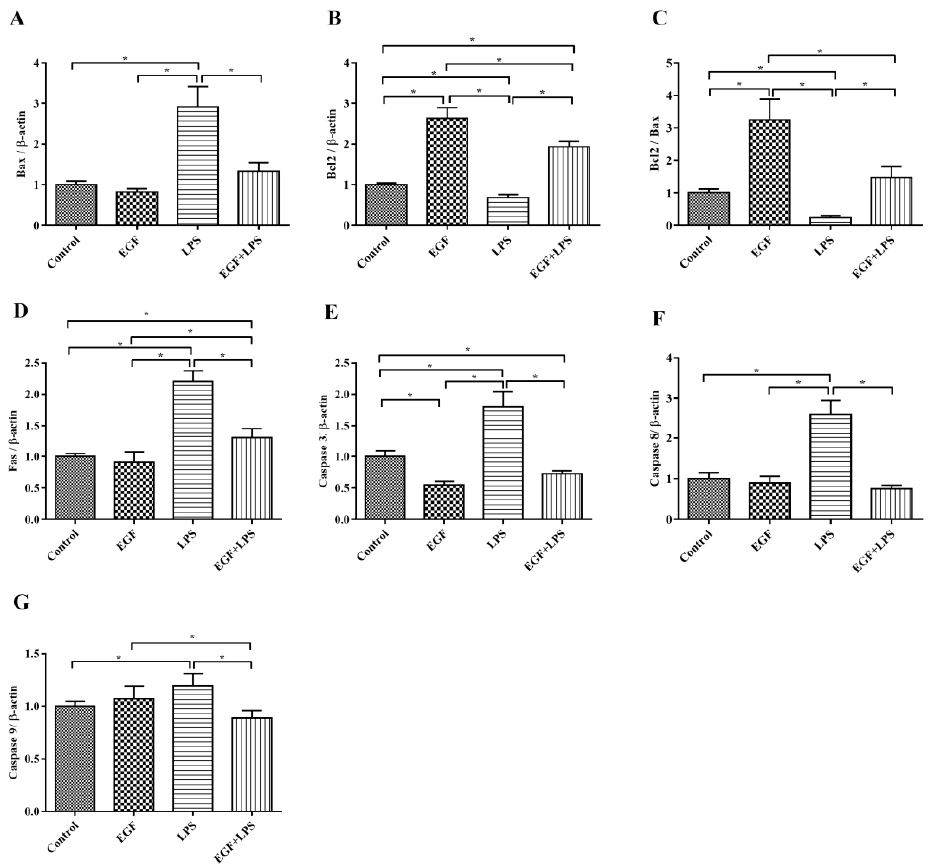
Figure 6. Effects of EGF on pro-apoptotic and anti-apoptotic genes expression induced by LPS. ( A ) Bax ; ( B ) Bcl2 ; ( C ) Bcl2 / Bax ; ( D ) Fas ; ( E ) Caspase 3 ; ( F ) Caspase 8 ; ( G ) Caspase 9 . All densitometric values were normalized to β -actin and expressed as a relative level to control value. Data are presented as mean ± SD, n = 3, * p < 0.05.